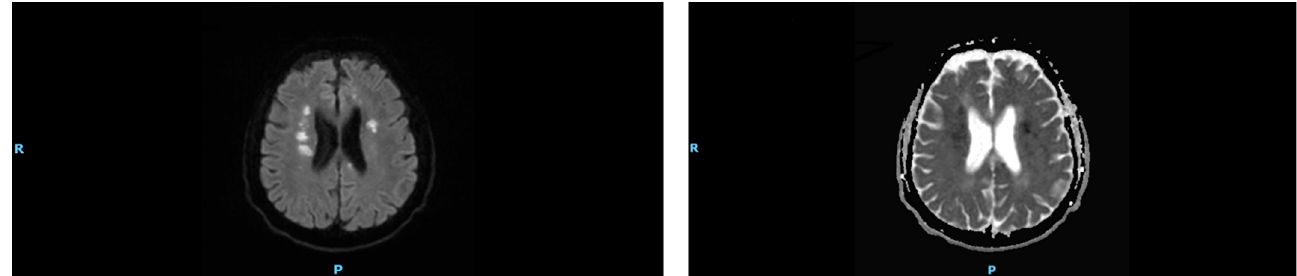
Figure 1. MRI brain showing high signal change in the diffusion-weighted sequence ( right ), with corresponding hypointensity in the periventricular and left frontal subcortical area in an apparent diffusion coefficient (ADC) map ( left ).